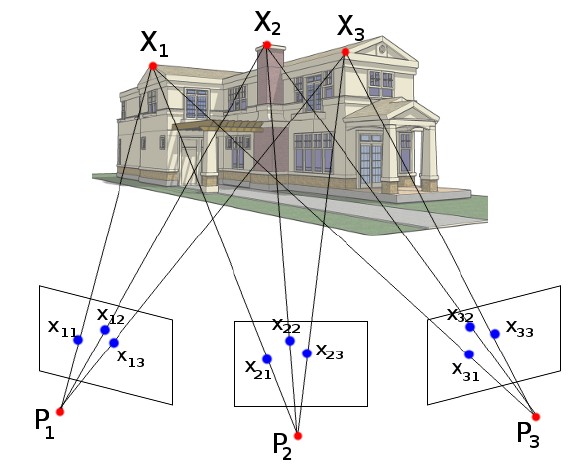
Figure 3: SFM projection